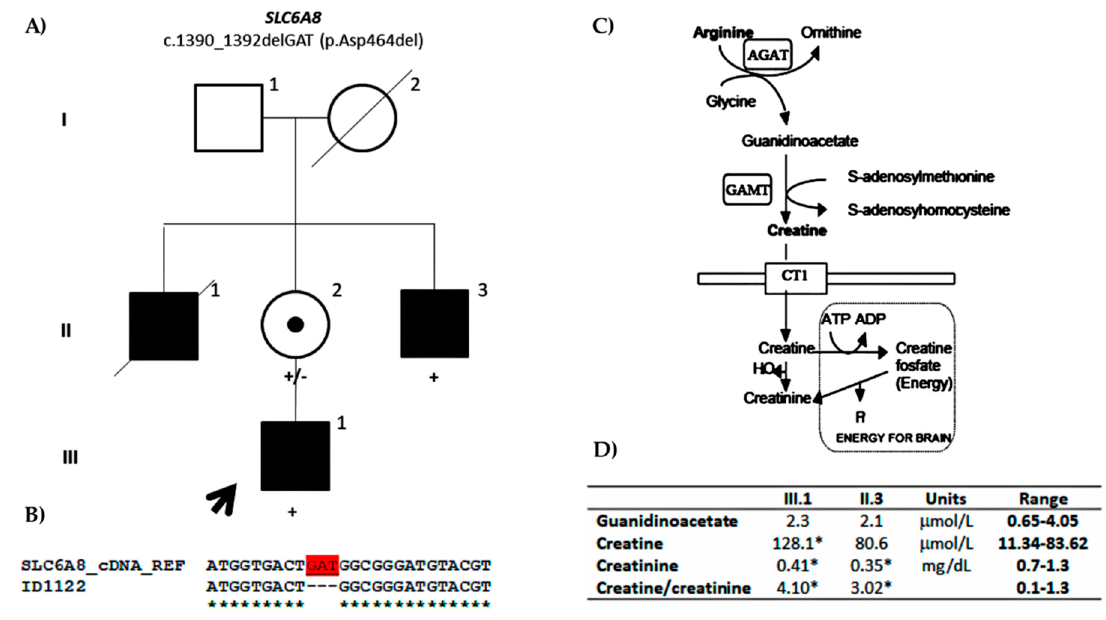
Figure 2. ( A ) Family pedigree of the ID1122 proband. Segregation of the c.1390_1392delGAT in-frame deletion in SLC6A8 (NM_005629.3) is shown. ( B ) Partial cDNA sequence of the SLC6A8 gene. cDNA sequence of the proband aligned to the reference SLC6A8 cDNA sequence is shown. The deleted nucleotides are shown in red. ( C ) Creatine metabolism pathway (derived from Andrade et al. 2008) [42]. The protein encoded by SLC6A8 is named creatine transporter (CT1) and it is a transmembrane protein that is responsible for the creatine uptake. ( D ) Plasma levels of guanidinoacetate, creatine, and creatinine in the proband (III.1) and a ff ected maternal uncle (II.3) are shown together with the creatine / creatinine ratio. The asterisk indicates the values that fall out of the reference range values.